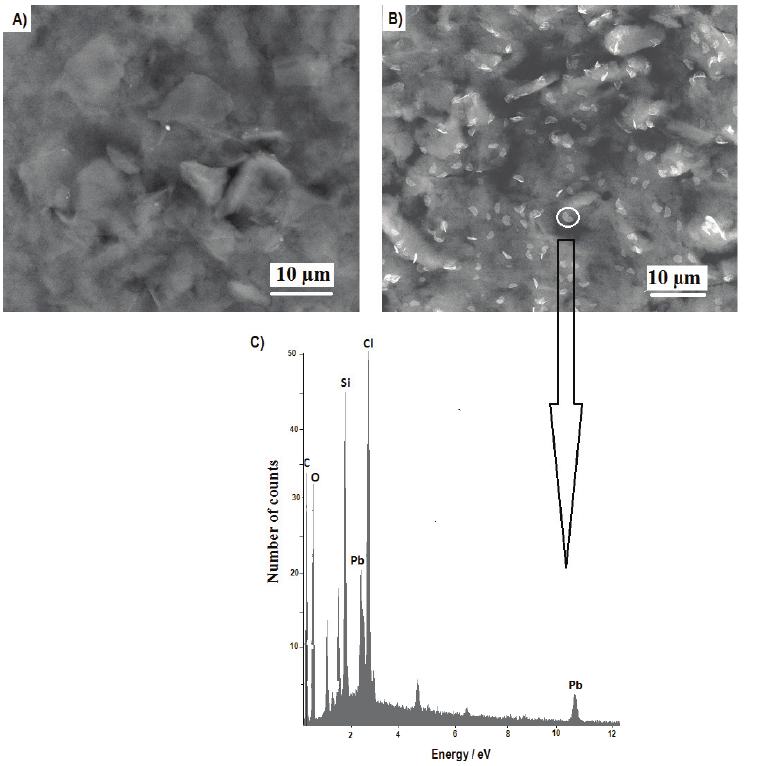
Figure 3. SEM images of lead fi lm electrode surface prepared without (A) and with (B) the use of a zinc mediator. The solution for electrode preparation contained 0.1 mol L -1 acetate buff er pH = 4.6 ± 0.1, 2 × 10 -5 mol L -1 Pb(II) and 0 (A) or 1 × 10 -5 mol L -1 (B) Zn(II). Zn and Pb were deposited at -1.6 V for 180 s. The potential and time of zinc oxidation and further deposition of lead were -0.95 V and 5 s, respectively. The EDS spectrum of highlighted fragment of the lead fi lm electrode surface prepared with the mediator (C).